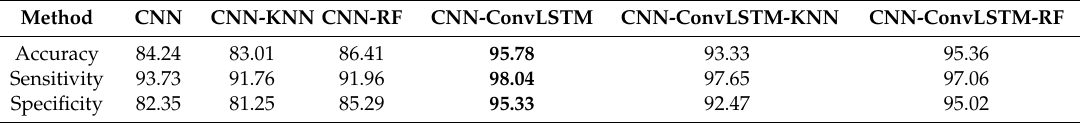
Table 5. Accuracy, sensitivity and specificity of the schemes in the leave-one-subject-out cross